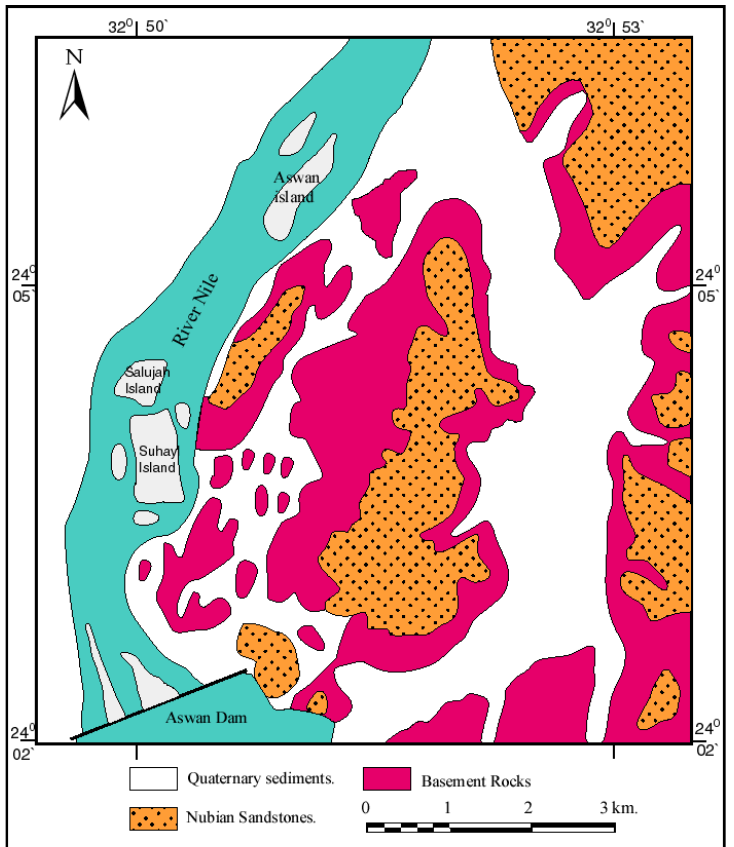
Figure 2. Geological map of Aswan area (modified after Hamdan and Rady [35]).